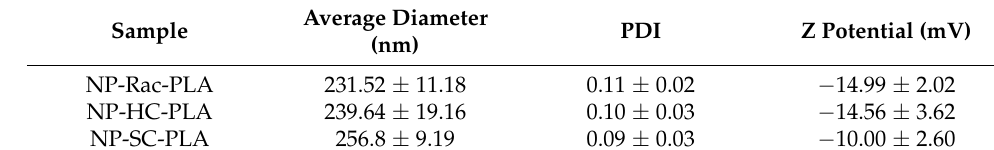
Table 2. DLS characterization of PLA nanoparticles.